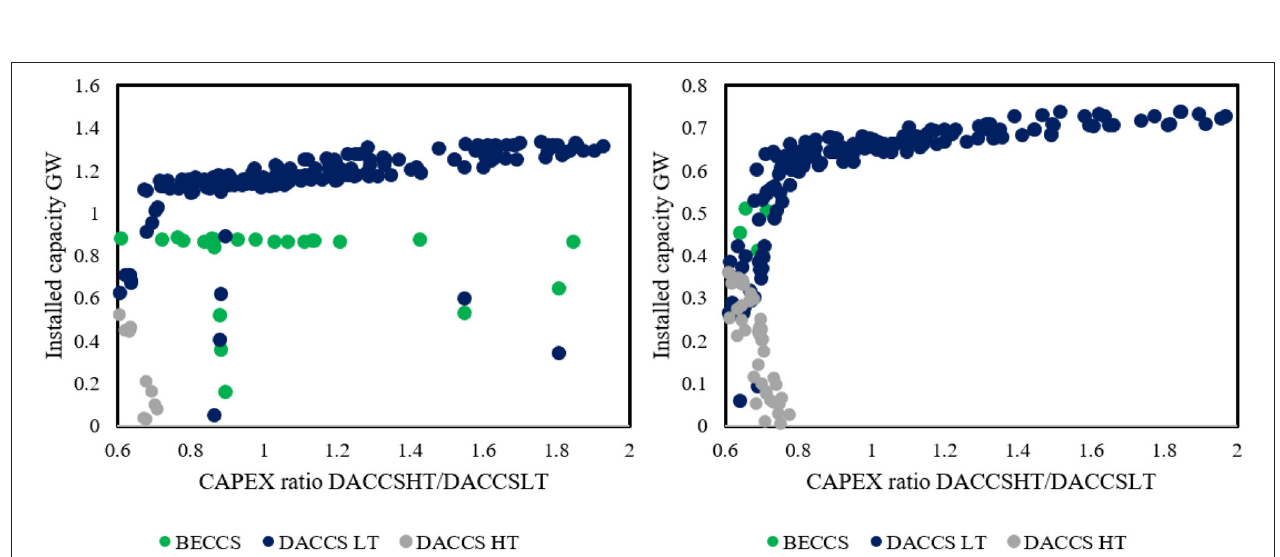
FIGURE 7 | The installed capacity of NETs compared to the cost of biomass in the regions ES3 (sunny) to the left and IE (windy) to the right respectively.